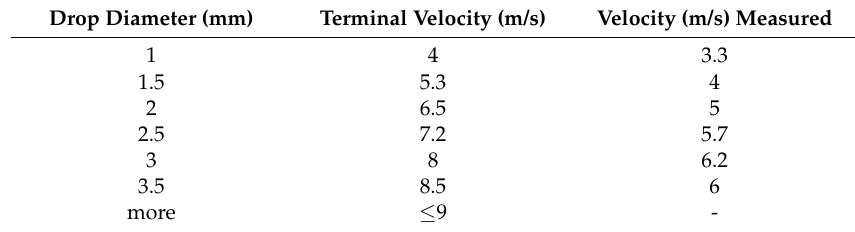
Table 2. Comparison of measured raindrop velocity and terminal velocity with respect to drop diameter (Lows and Parson,